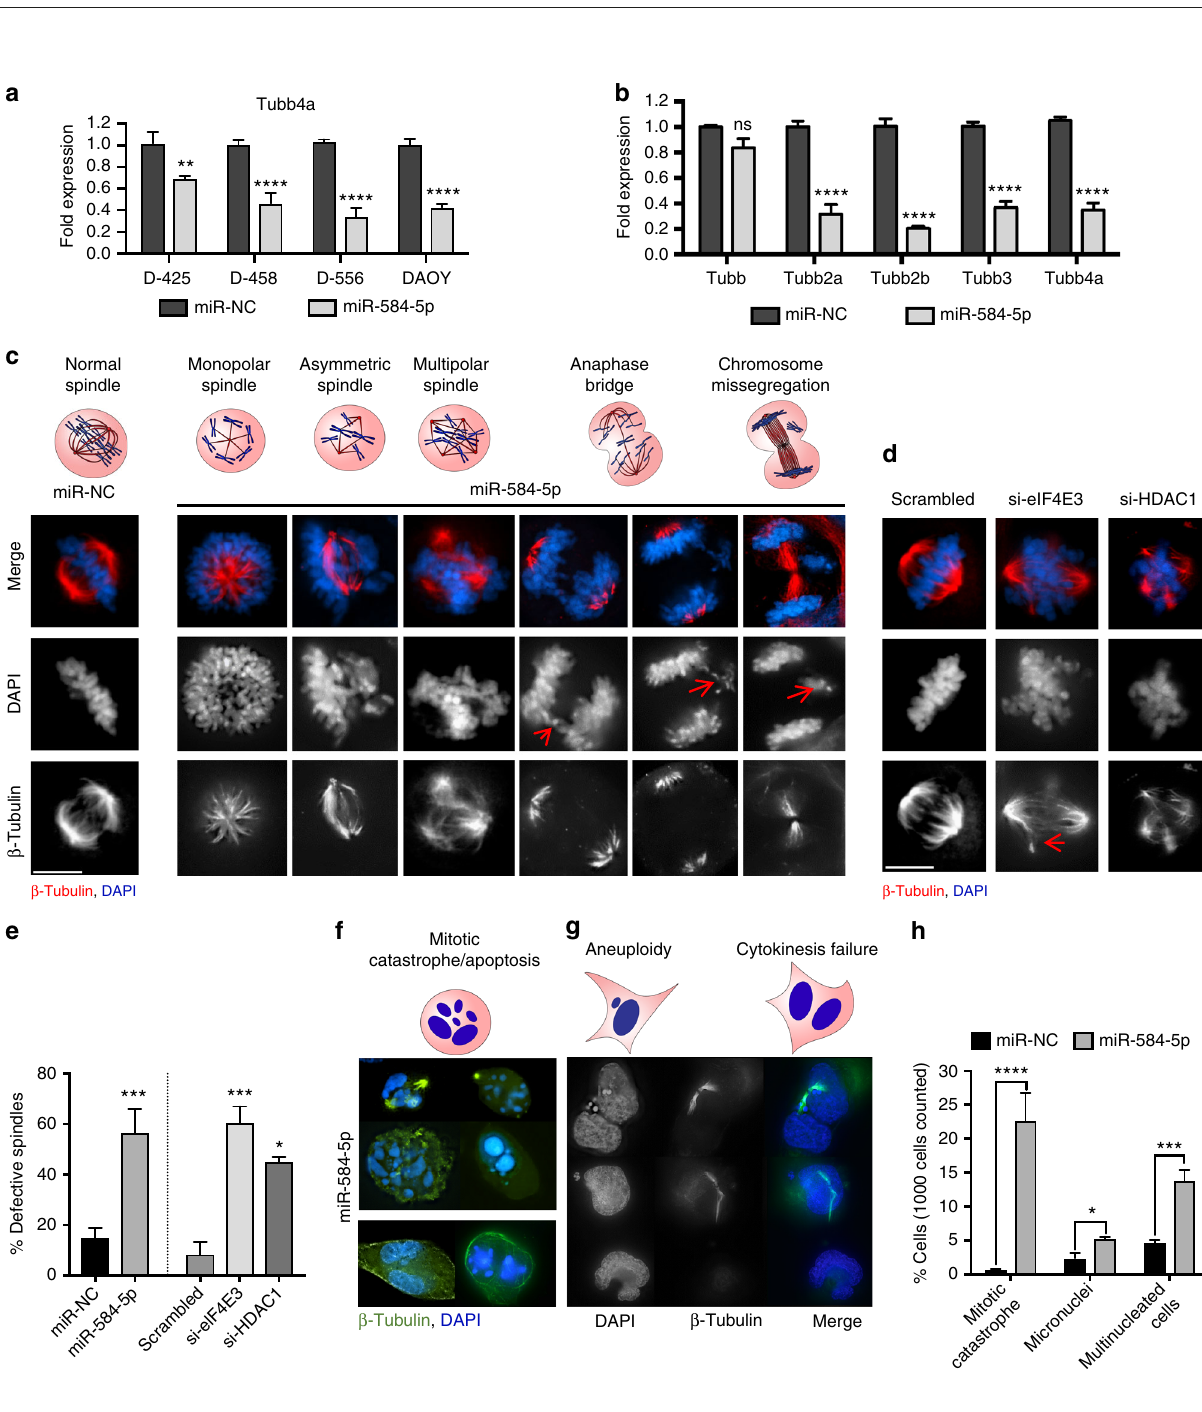
Fig. 6 MiR-584-5p – HDAC1/eIF4E3 signaling regulates cell cycle progression of MB cells. a Bar graphs show quanti fi cation of DNA histograms (using FlowJo software) re fl ecting cell cycle progression in D556Med cells transfected with miR-NC or miR-584-5p and treated with vehicle or vincristine (VCR). DNA histograms were obtained from FACS analysis of cells treated with miR-NC or miR-584-5p and treated with vehicle or vincristine (VCR). Error bars represent mean ± SEM of three independent experiments. b Bar graphs show FACS analysis of Histone H3 pSer10-positive D-556 cells transfected with miR-NC or miR-584-5p and treated with vehicle or VCR. The p -values were calculated using standard Student t -tests. Error bars represent mean ± SEM of three independent experiments. c FACS analysis of cell cycle progression in D556Med cells transfected with scrambled-siRNA or eIF4E3-siRNA or HDAC1- siRNA. Bar graphs re fl ect DNA histograms quanti fi ed using the FlowJo software. Error bars represent mean ± SEM of three independent experiments. d FACS analysis of Annexin V – FITC-positive cells in D556Med cells transfected with miR-NC or miR-584-5p and treated with vehicle or VCR. Bar graphs show dot plots quanti fi ed using the FlowJo software. Error bars represent mean ± SEM of three independent experiments. e FACS analysis of Annexin V – FITC-positive cells in D556Med cells transfected with scrambled-siRNA or eIF4E3-siRNA or HDAC1-siRNA. Bar graphs show dot plots quanti fi ed using the FlowJo software. Error bars represent mean ± SEM of three independent experiments. The p -values for d – e were determined by two-way ANOVA followed by Tukey ’ s multiple-comparisons test. **** p < 0.0001; *** p < 0.001; ** p < 0.01; * p <